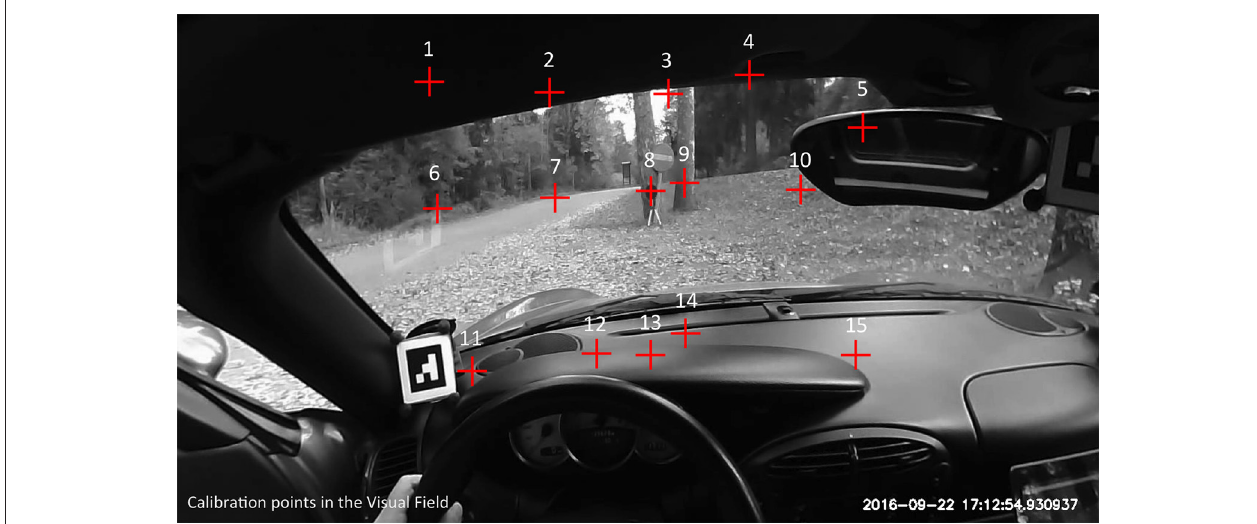
FIGURE 1 | Locations of the calibration points in the (head centered) visual field. Note that instead of multiple targets, we used a single target (on the tripod, at fixation point 8). The participant was instructed to adopt different head poses that moved the target to different locations in the visual field.